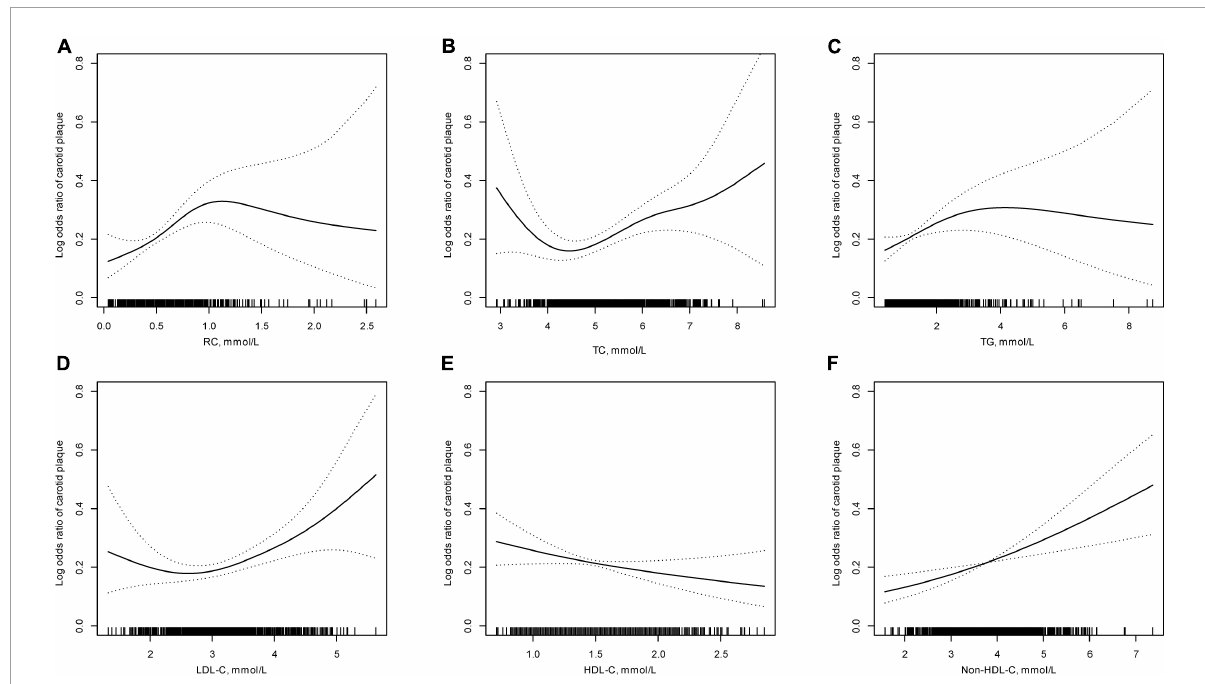
FIGURE1 The relationship between lipid parameters and new-onset carotid plaque*. (A) Remnant lipoprotein cholesterol (RC); (B) total cholesterol (TC); (C) triglycerides (TG); (D) low-density lipoprotein cholesterol (LDL-C); (E) high-density lipoprotein cholesterol (HDL-C); and (F) Non-HDL-C. *Adjusted for: sex, age, body mass index, current drinking, current smoking, estimated glomerular filtration rate, diabetes mellitus, hypertension, antihypertensive, and hypoglycemic